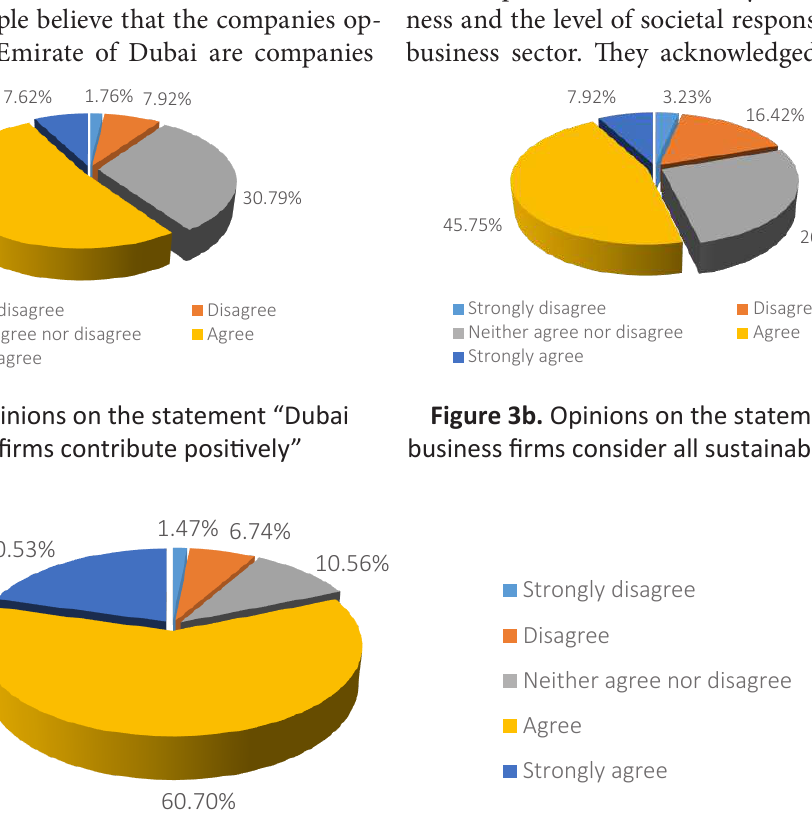
Figure 4. Opinions on the statement “Dubai business firms would operate more sustainably if community expressed more interest”